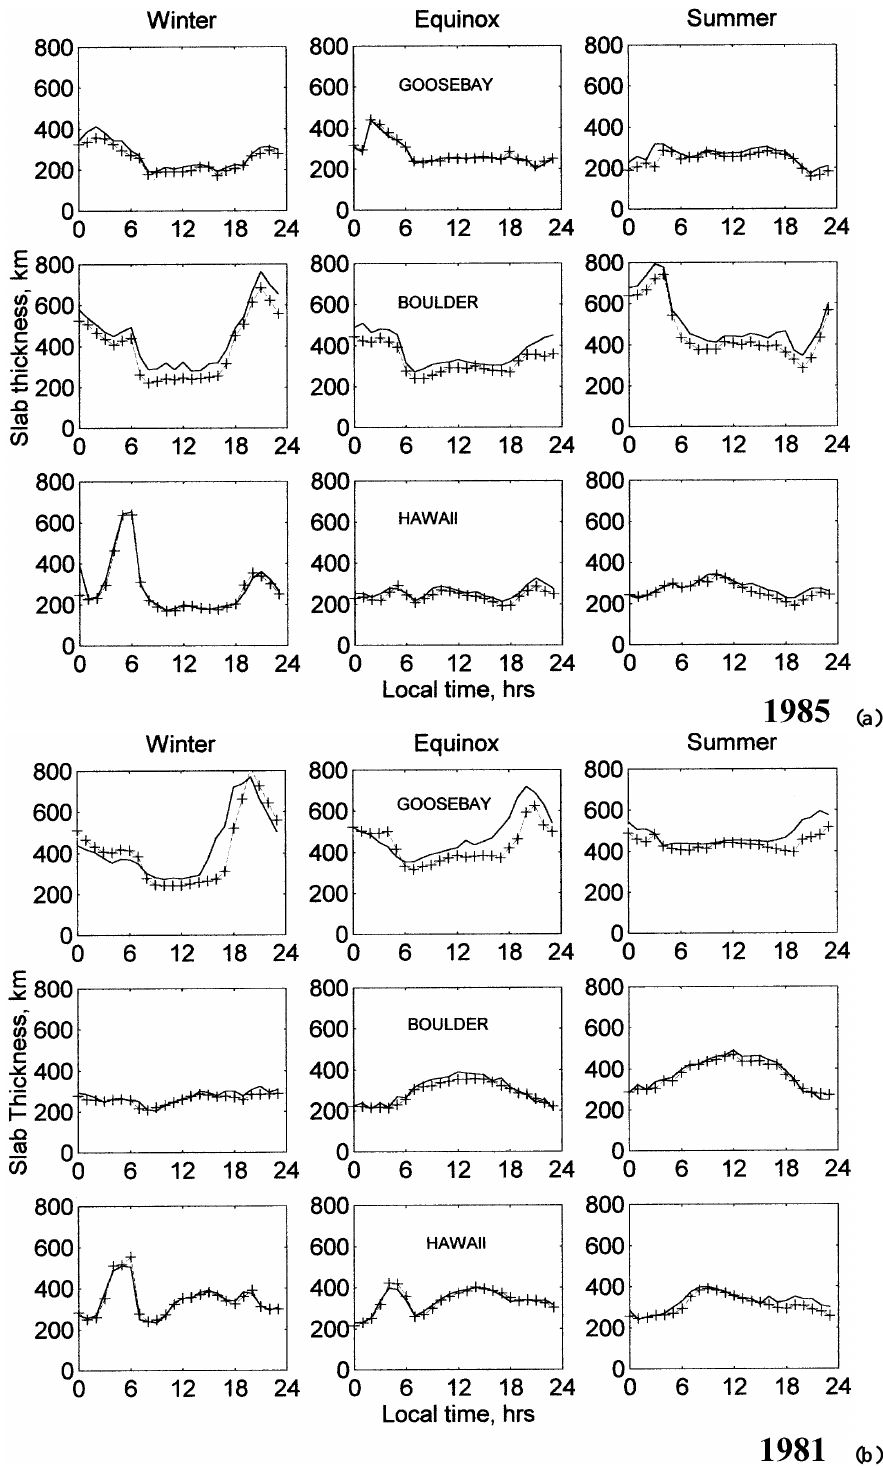
Fig. 2. Seasonal variations of slab thickness for Hawaii, Boulder and Goosebay during (a) solar minimum year 1985, and (b) solar maximum year 1981 (.x x quiet days, all